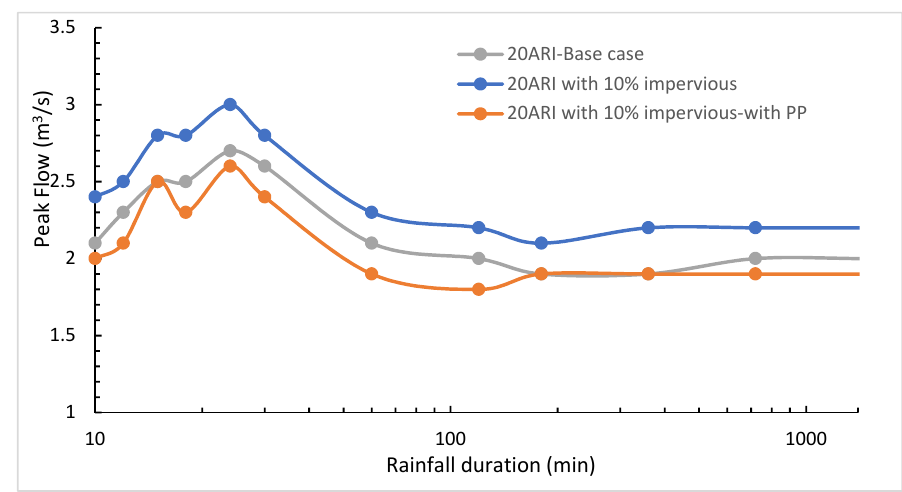
Figure 7. Discharges for 20-Year ARI events with 10% increase in imperviousness.